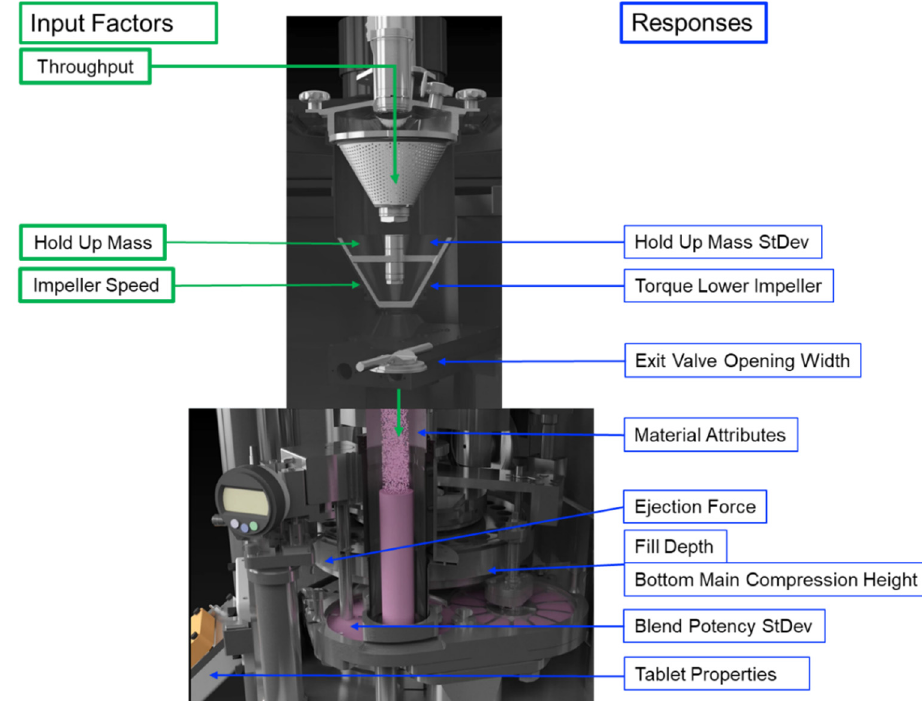
Figure 4. Process overview of input factors (green, left side) and observed responses (blue, right side).